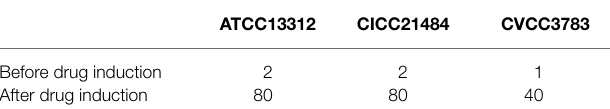
TABLE 1 | MIC values of Apramycin against different Salmonella before and after drug induction ( μ g/ml).